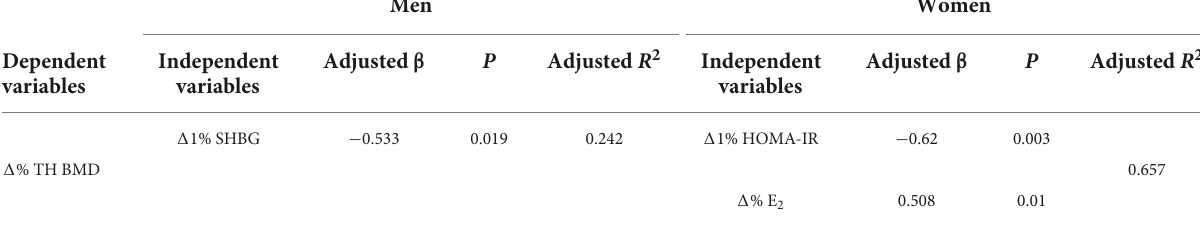
TABLE 4 Multiple stepwise regression analysis of potential factors associated with TH BMD